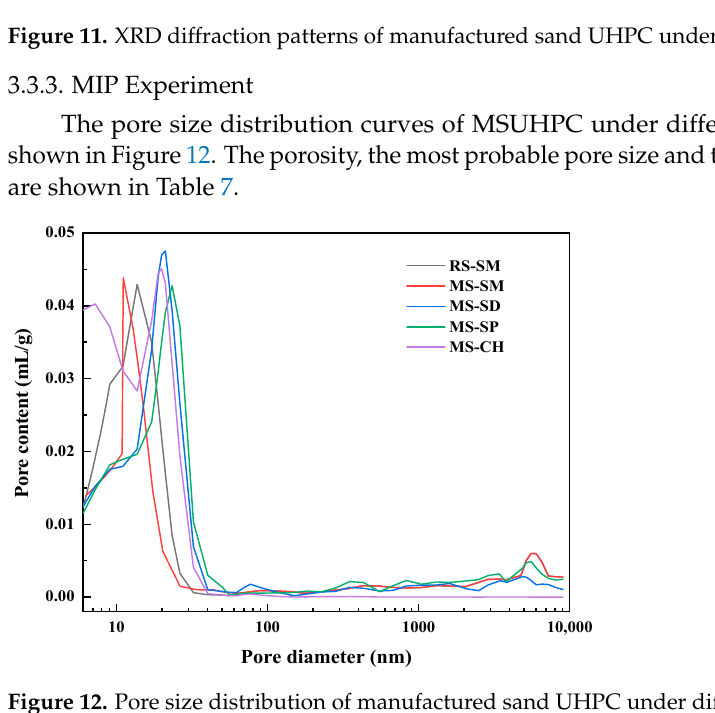
Figure 12. Pore size distribution of manufactured sand UHPC under different curing methods. Table 7. Pore index of manufactured sand under different curing methods. Specimen NO.